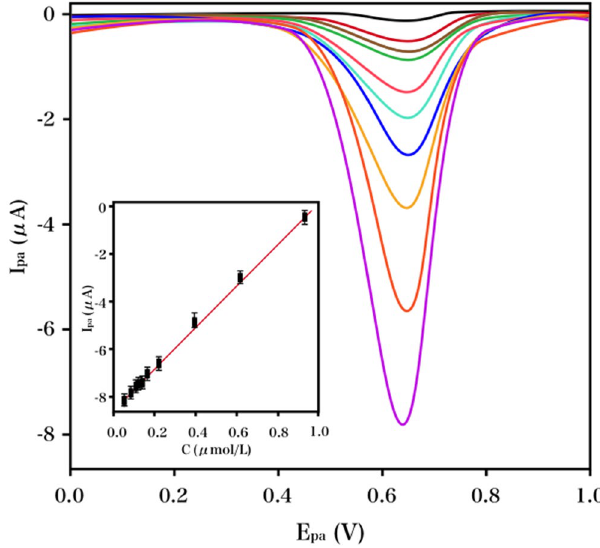
Figure 7. DPV profiles of NGF at RGO–TiN/GCE in PB (0.1 M, pH 8.0) containing varying concentrations of NGF. Insert: linear calibration curve.